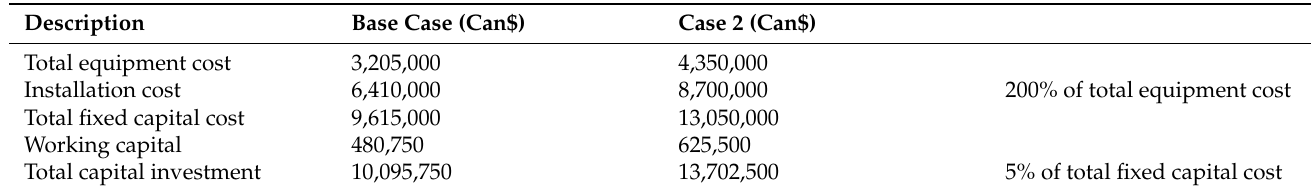
Table 3. Total capital investment in the (i) base case and (ii) case 2.